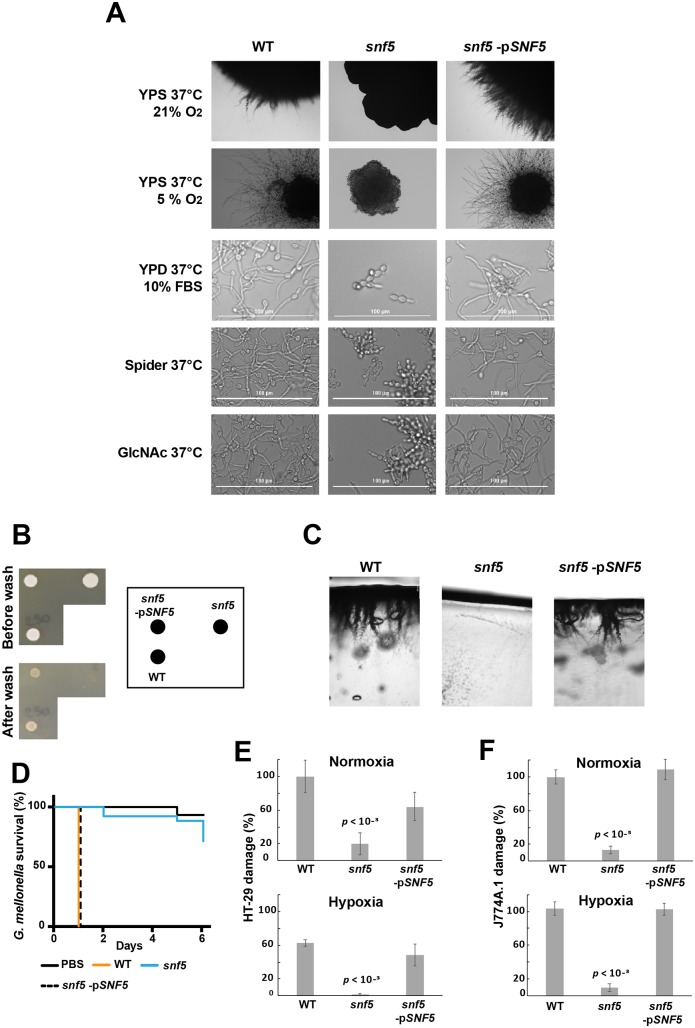
Snf5 is required for host invasion and hyphae formation in response to different cues.(A) Colony morphologies of the WT, snf5 and the complemented strain after four days at 37°C on solid YPS medium under both normoxia (21% O2) and hypoxia (5% O2), or growing in in liquid Spider, and YPD media supplemented with either 10% fetal bovine serum (FBS) or 2.5 mM N-acetyl-D- glucosamine (GlcNAc) for 3 hours. (B-C) Agar invasion assay. Exponentially growing WT, snf5 and revertant strains were seeded on YPD agar plate and incubated for 3 days at 30°C. (B) The plates were photographed before and after being washed with PBS. (C) Agar sections were also performed and photographed. (D) snf5 has reduced virulence in the G. mellonella-C. albicans model of systemic infection. WT, snf5 and the revertant strains and control PBS were injected to G. mellonella larvae and survival was monitored daily for a period of 6 days. SNF5 inactivation attenuates damage of the human colon epithelial HT-29 cells (E) and the murine macrophages J774A.1 (F) under both hypoxia and normoxia. HT-29 cell damage was assessed using the lactate dehydrogenase (LDH) release assay and was calculated as percentage of LDH activity in cell infected by snf5 and the revertant strains relatively to cells infected by the WT (SN250) strain. Macrophage viability was calculated as percentage of LDH activity in cell infected by the WT and the revertant strains relative to J774A.1 infected by the snf5 strain. Results are the mean of three independent replicates. Statistical significance was tested using the two-tailed Student’s t-test.